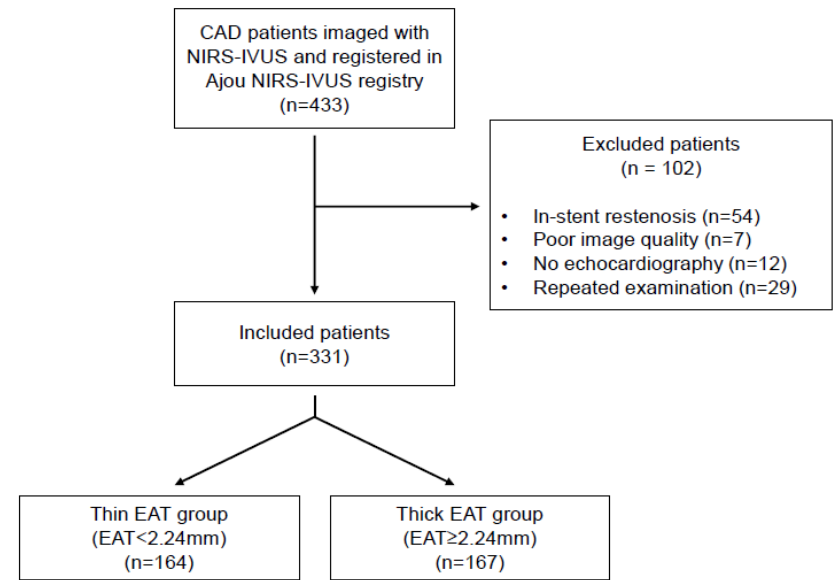
Figure 1. A flowchart of this study.